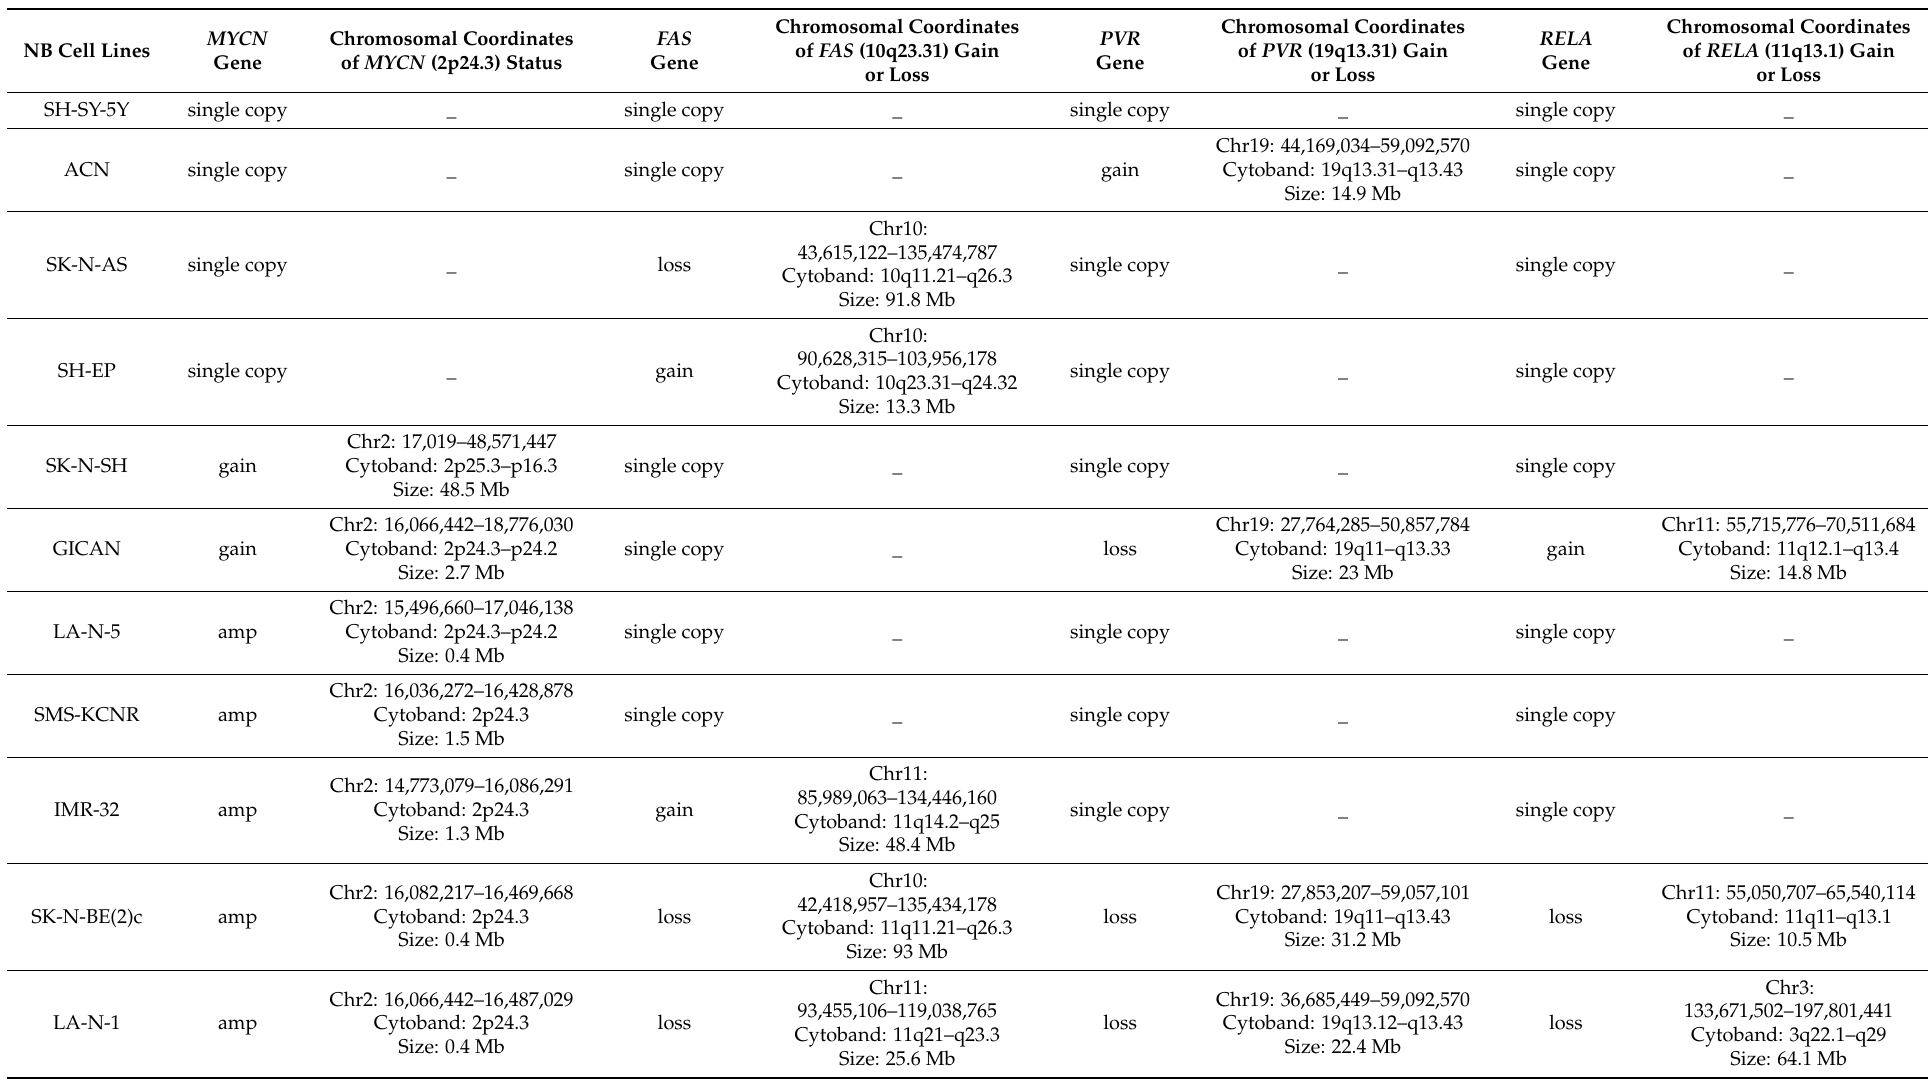
Table 1. Status of MYCN , FAS , PVR, and RELA genes in NB cell